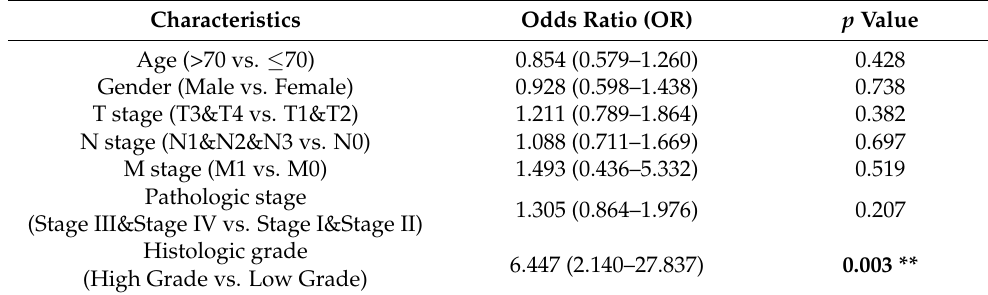
Table 1. Correlation between RRM2 expression and clinicopathological features in TCGA-BLCA patients ( n =